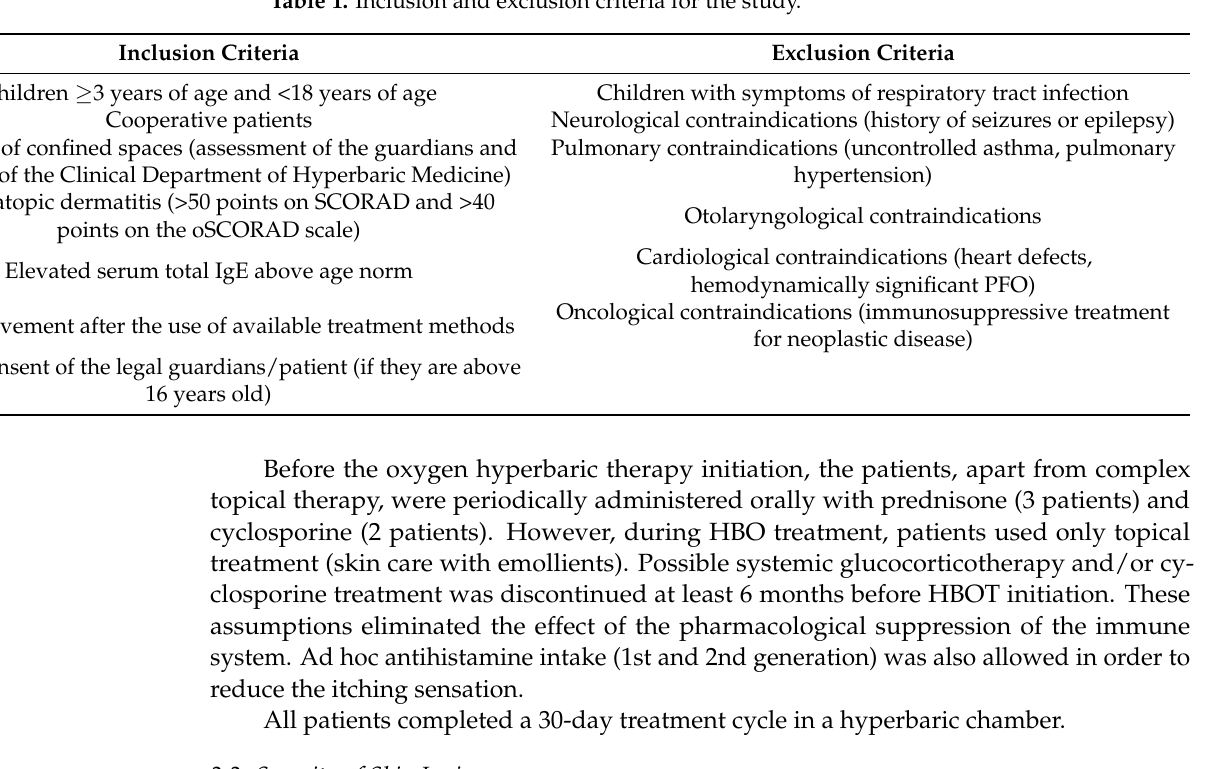
Table 1. Inclusion and exclusion criteria for the